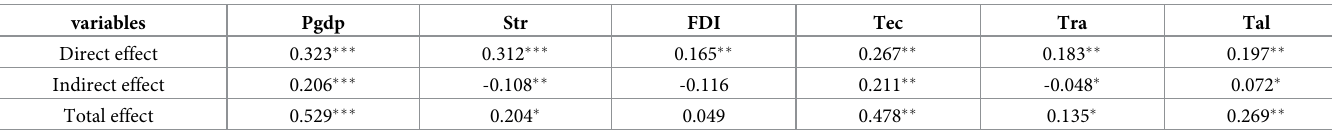
Table 7. Decomposition results of spatial